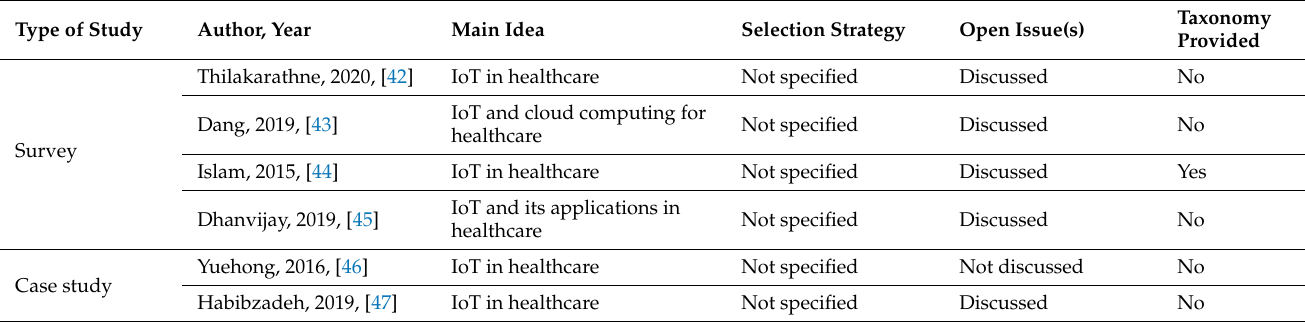
Table 1. Literature review of related